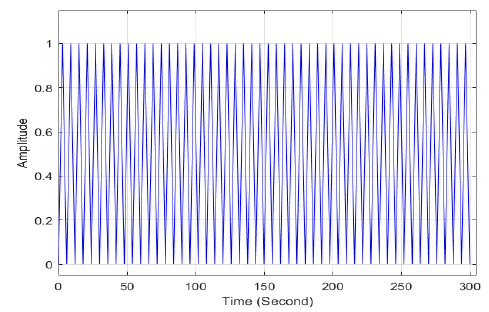
Figure 9. Time vs. amplitude graph.